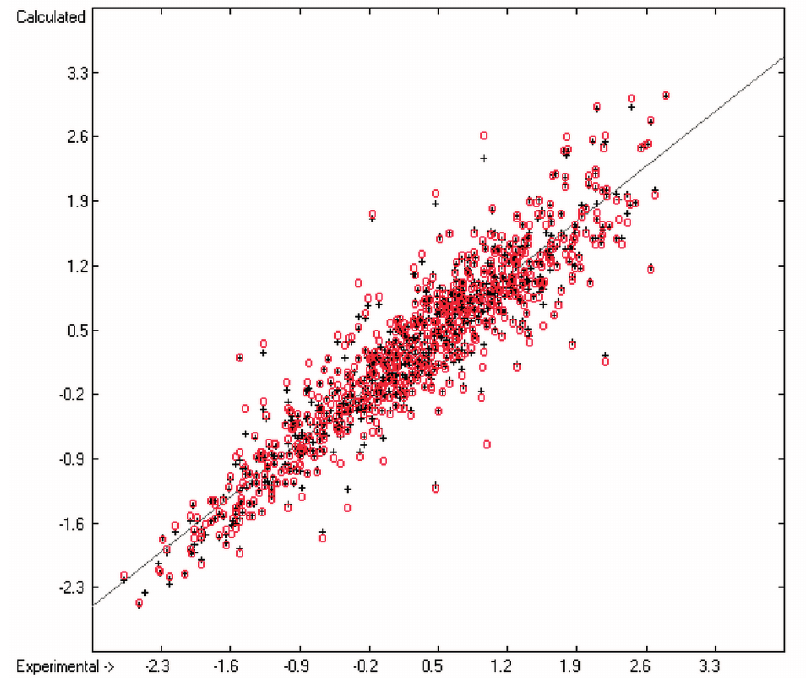
Figure 17. Correlation diagram of toxicity data (10-fold cross-validated: N = 810, Q 2 = 0.8404, slope = 0.85).